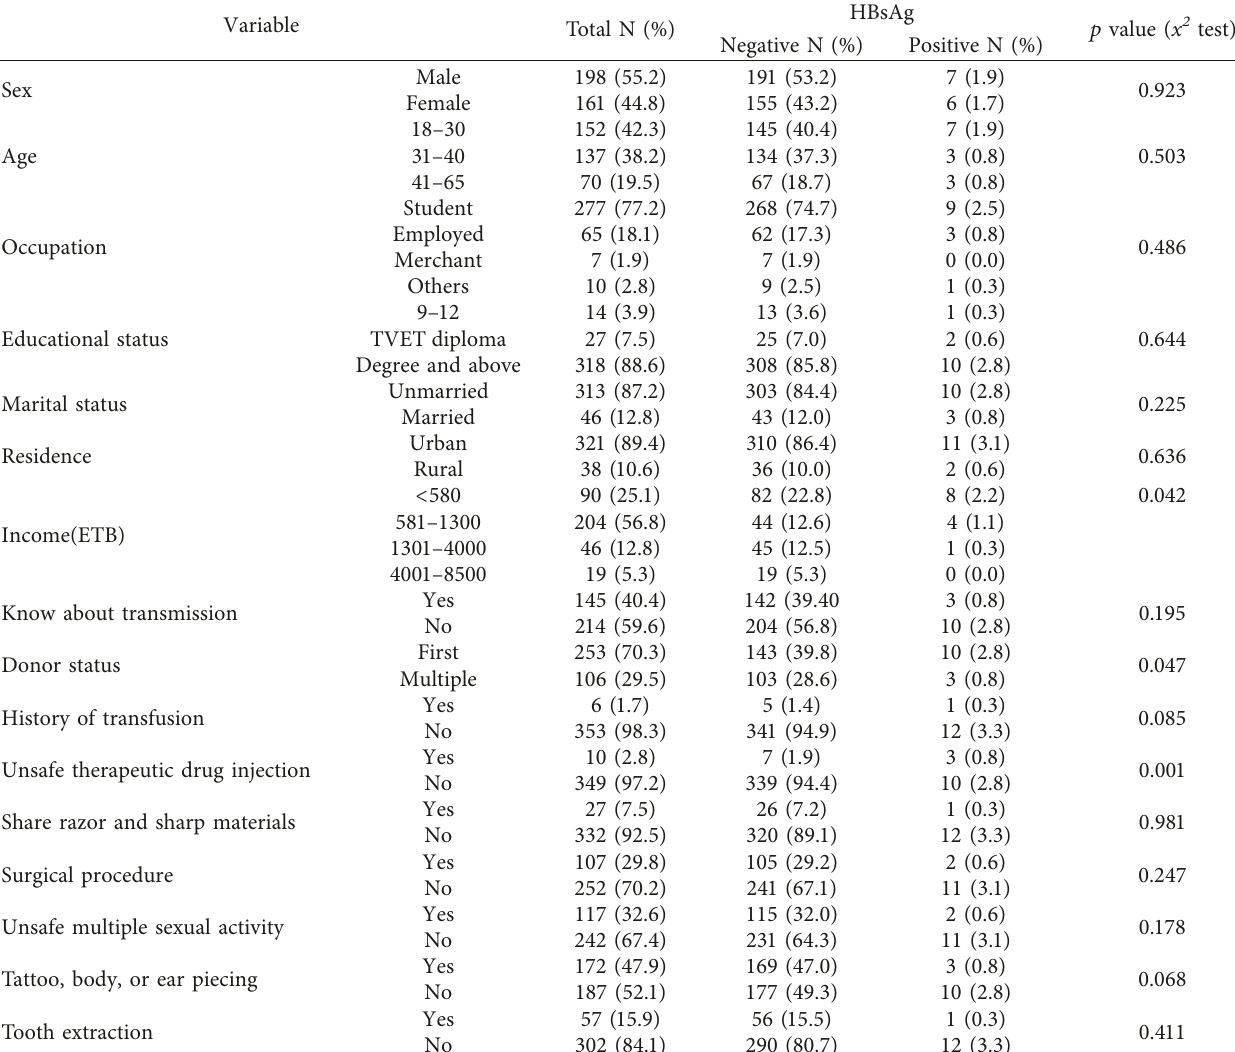
Table 1: Sociodemographic characteristics of participants in association with the